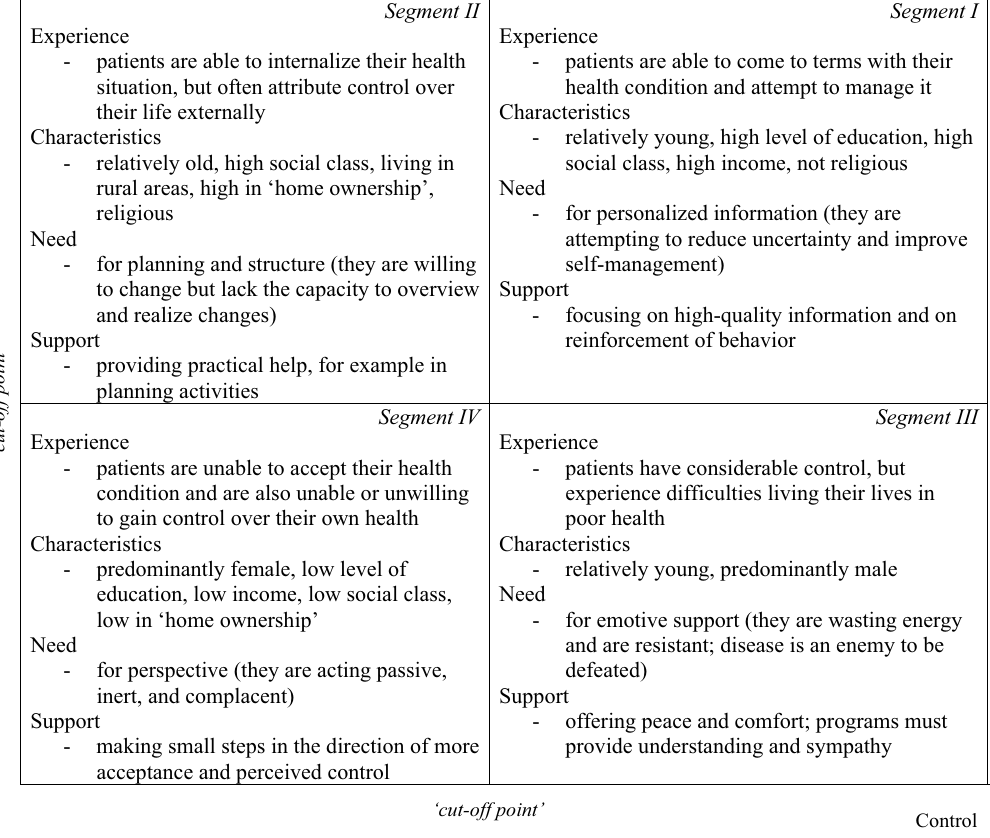
Figure 1. Updated Bloem & Stalpers model of subjective health